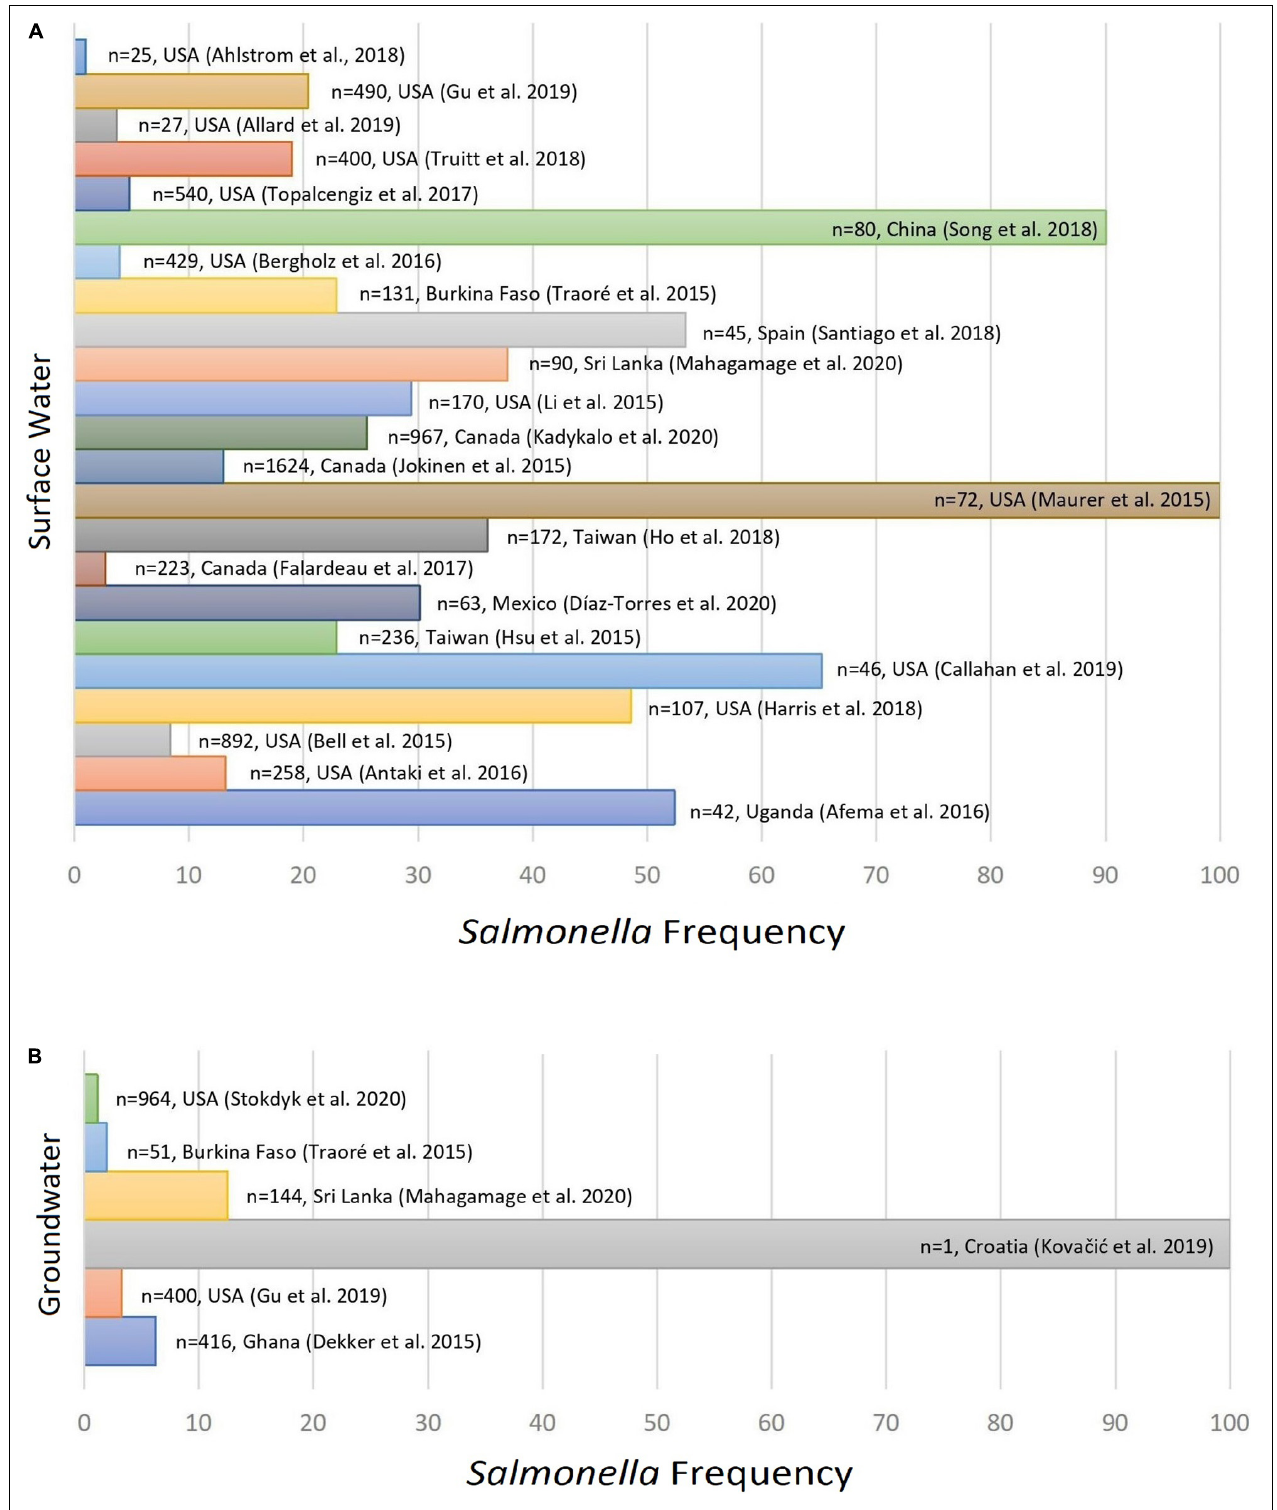
FIGURE 2 | Frequency of Salmonella enterica serovars detected in non-recycled surface water (A) and groundwater samples (B) as per reported in 26 peer reviewed scientific publications between the years 2015 and 2020.